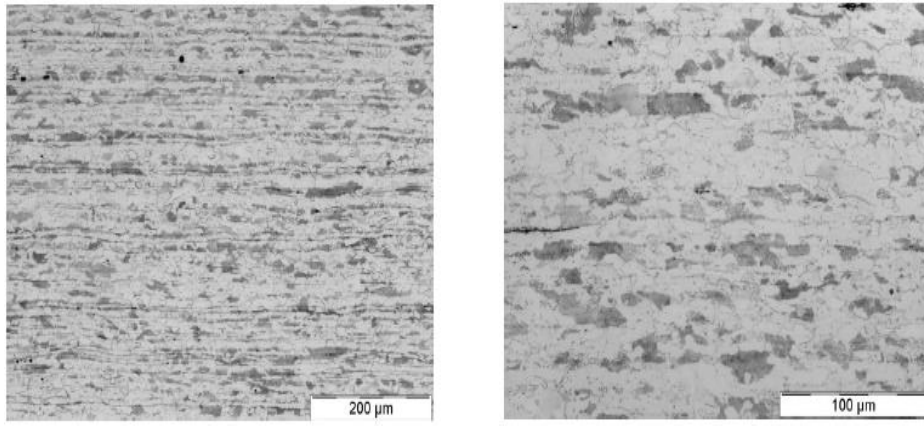
Figure 1. Initial microstructure of the studied 6.2 mm thick 22MnB5 material. Table 2. Summary of heat treatment conditions applied.